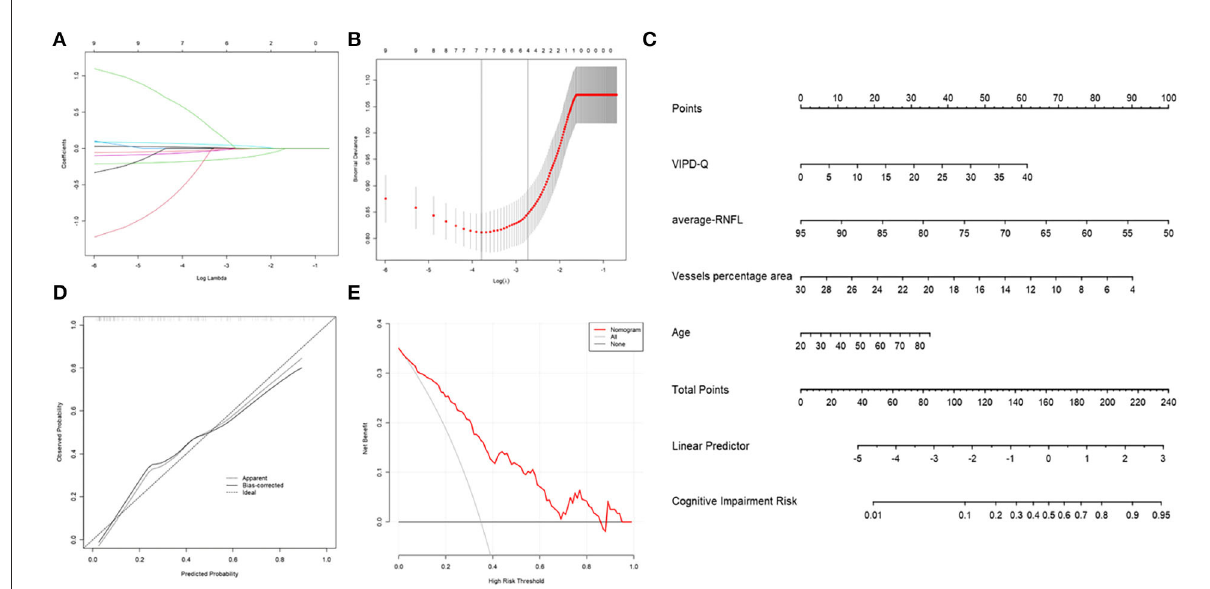
FIGURE5 Nomogram of ophthalmic parameters predicting the risk of cognitive impairment in PD. (A) LASSO regression analysis was conducted to screen out MoCA score-related parameters. (B) Bootstrap validation was performed to verify the screened event. (C) A nomogram predicting the risk of cognitive impairment in PD was constructed based on ophthalmic parameters. (D) A calibration curve was drawn to decrease the bias of the nomogram. (E) A DCA curve showed that the nomogram would benefit patients with PD by accurately predicting the risk of cognitive impairment. DCA, decision curve analysis; PD, Parkinson’s disease; MoCA, Montreal Cognitive